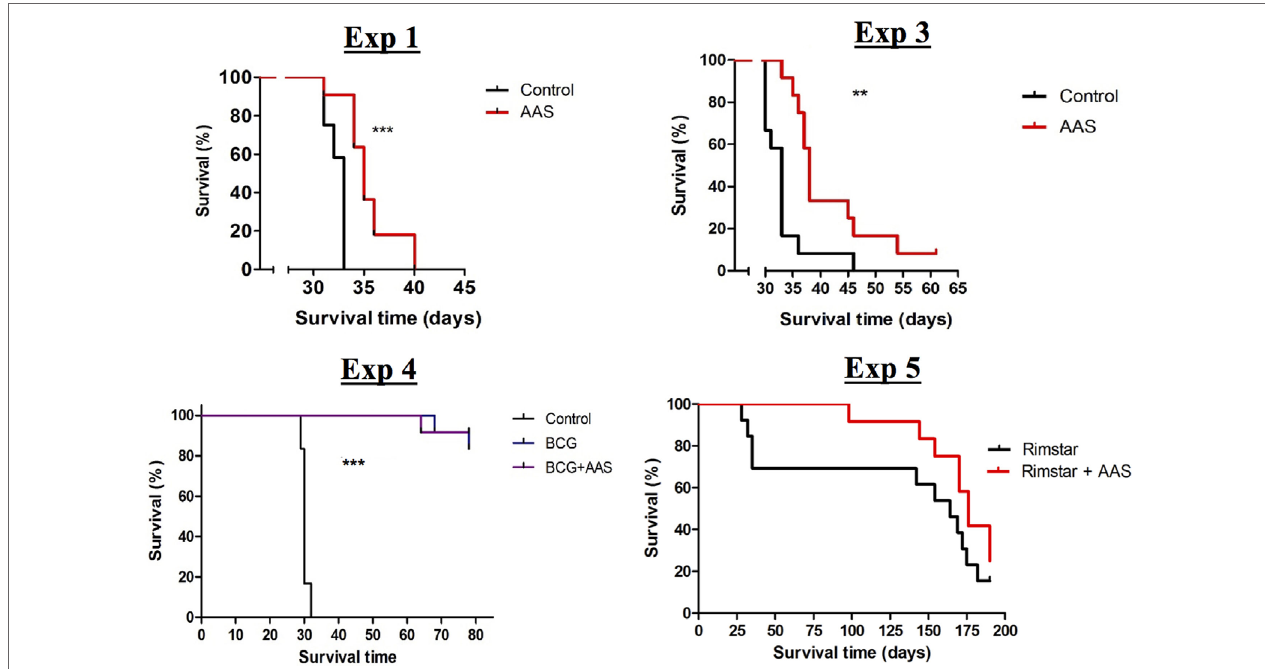
FigUre 1 | Survival assessment. Curves for the experimental groups achieved in the four experiments in which the impact of treatment on survival was assessed. Abbreviations: AAS, aspirin; BCG, bacille Calmette–Guerin vaccine; Vacc., vaccination; RIMSTAR, rifampicin 150 mg + isoniazid 75 mg + pyrazinamid 400 mg + ethambutol 275 mg, adjusted to mouse